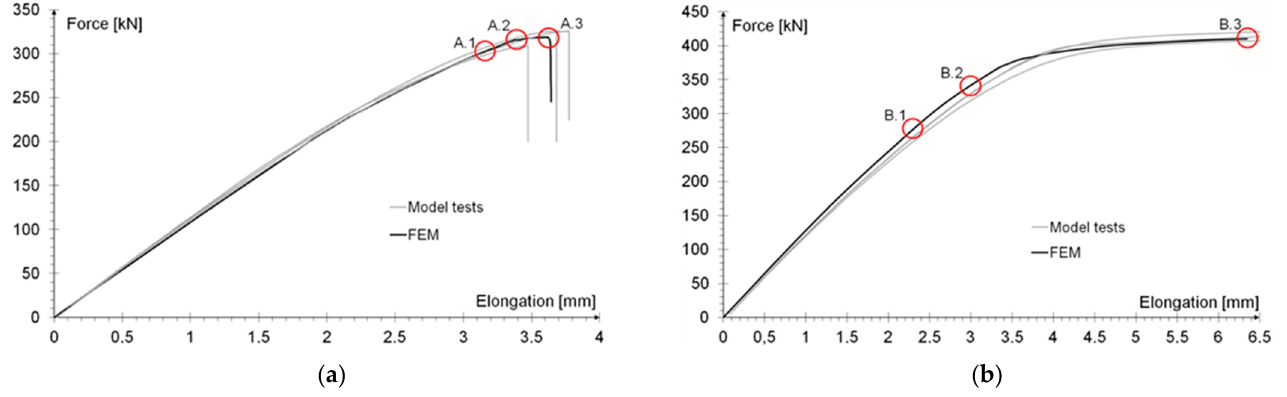
Figure 17. Comparison of force-elongation relationships from laboratory tests and numerical anal- ysis for specimens with effective joint length of: ( a ) 200 mm; ( b ) 400 mm.